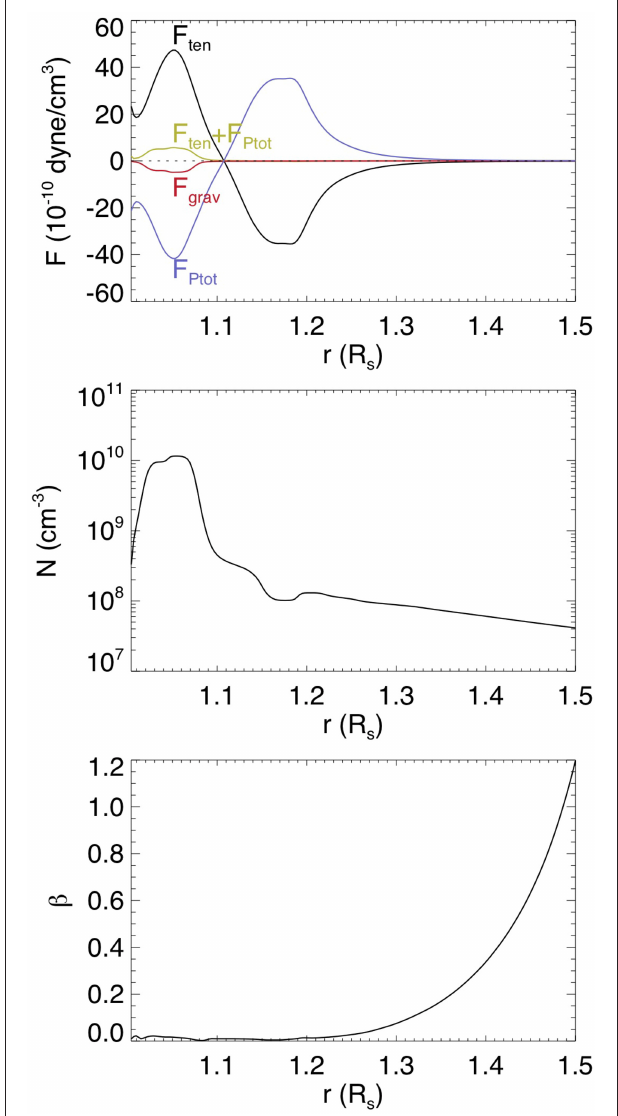
FIGURE 5 | Several radial forces (Top) , density (Middle) , and plasma- β (the ratio of gas pressure to magnetic pressure) (Bottom) along the central vertical line through the middle of the flux rope in Figure 2b . The radial forces shown in the top panel are the magnetic tension force F ten (black curve), the total pressure gradient force F Ptot (blue curve), which is predominantly the magnetic pressure gradient (because of the low plasma- β ) as shown in the bottom panel), the sum F ten + F Ptot (green curve), which is approximately the net Lorentz force, and the gravity force of the plasma F grav (red curve). as a function of